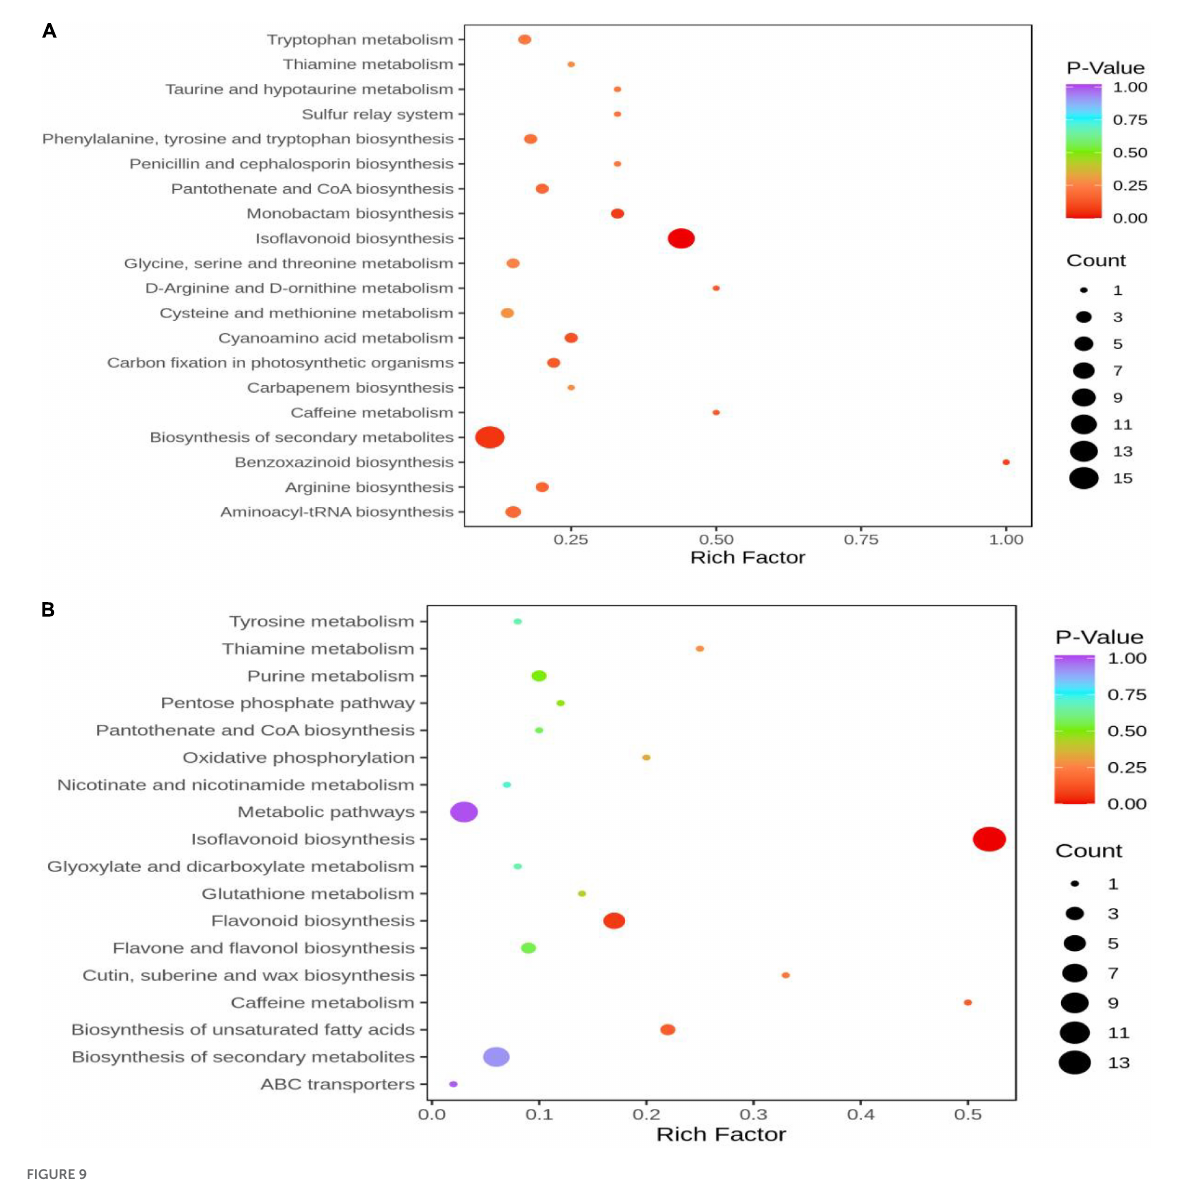
vs. HN44-DPC, the gene LOC100806561 encoding shikimate O-hydroxycinnamoyltransferase and the genes LOC100783085 and LOC100787507 encoding flavonoid 3’,5’-hydroxylase were downregulated. The gene LOC100820497